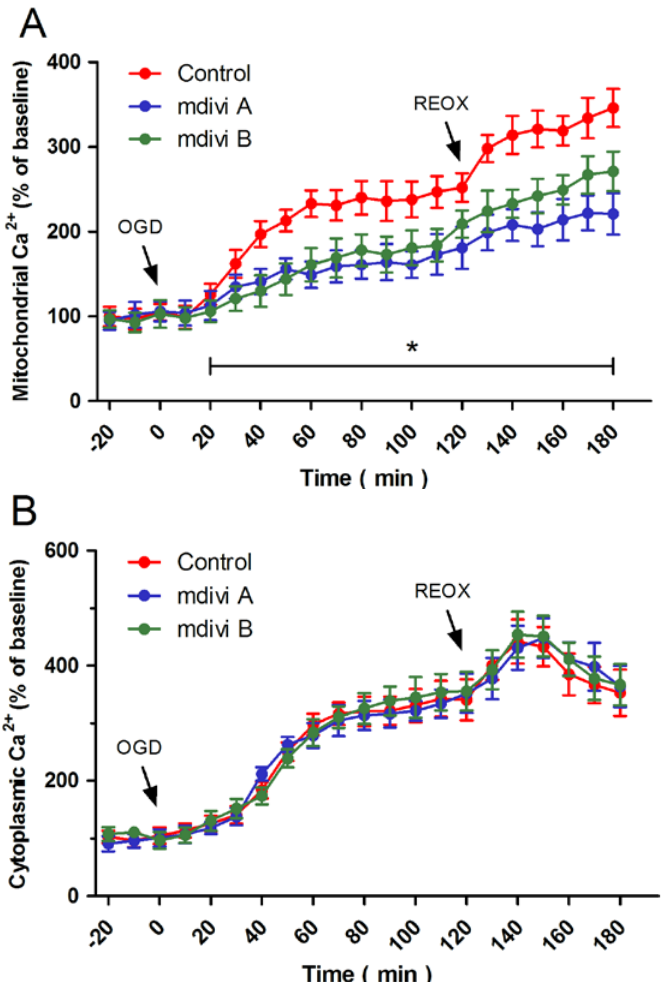
Figure 4. Effects of Drp-1inhibitors on mitochondrial Ca 2+ uptake. PC12 cells